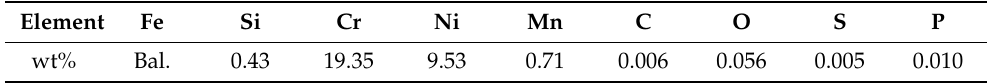
Table 1. Chemical composition of the 304L stainless steel powders.